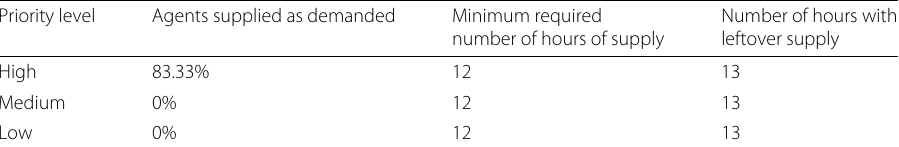
Table 5 Required supply reliability assessment of non-self-sufficient agents - all agents require to be supplied for 90% of the hours with leftover